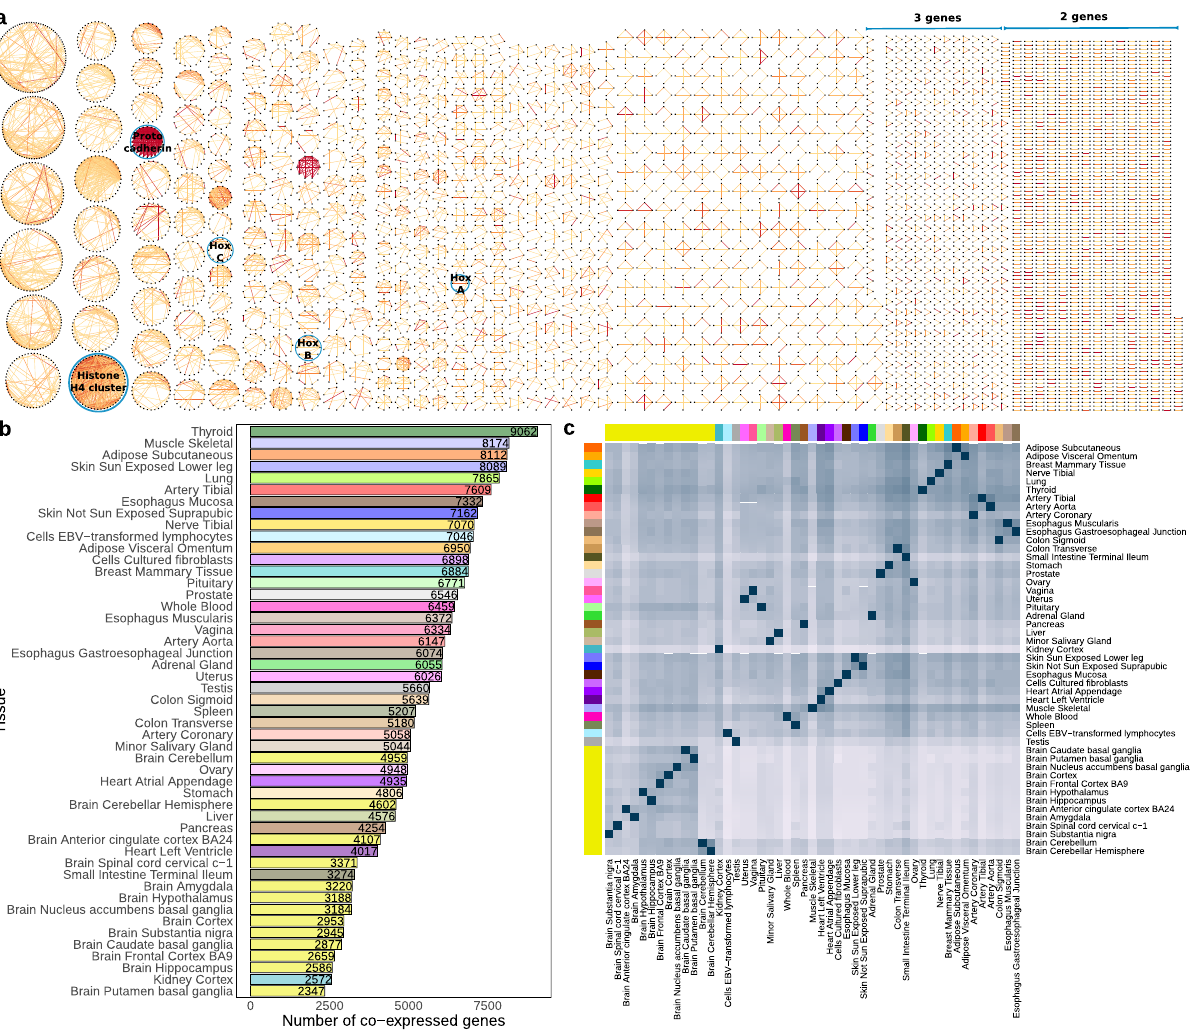
Fig. 2 Local gene co-expression discovery across tissues. a Grouping of Geuvadis LCL COP discovery into 2545 network components (genes as black nodes, correlation as edges), edge colour is mapped to correlation strength and several known gene clusters are highlighted. b Number of COPs identi fi ed in each GTEx tissue. c Clustering of COP sharing across GTEx tissues. For each pair of tissues (tissue A, tissue B), the percentage of COPs of tissue A that are also COPs in tissue B is calculated and used for clustering (hierarchical clustering). Higher blue colour intensity corresponds to a higher percentage of COPs